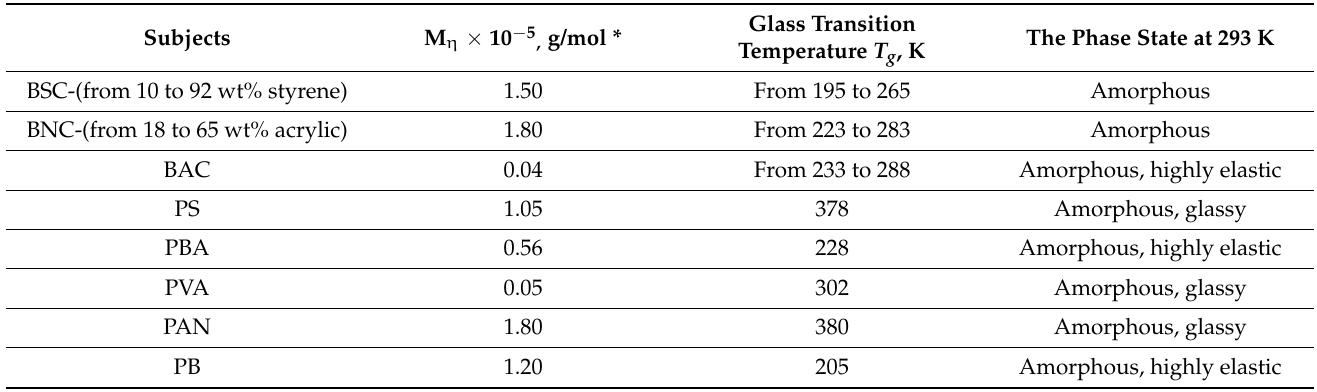
Table 1. Characteristics of copolymers and